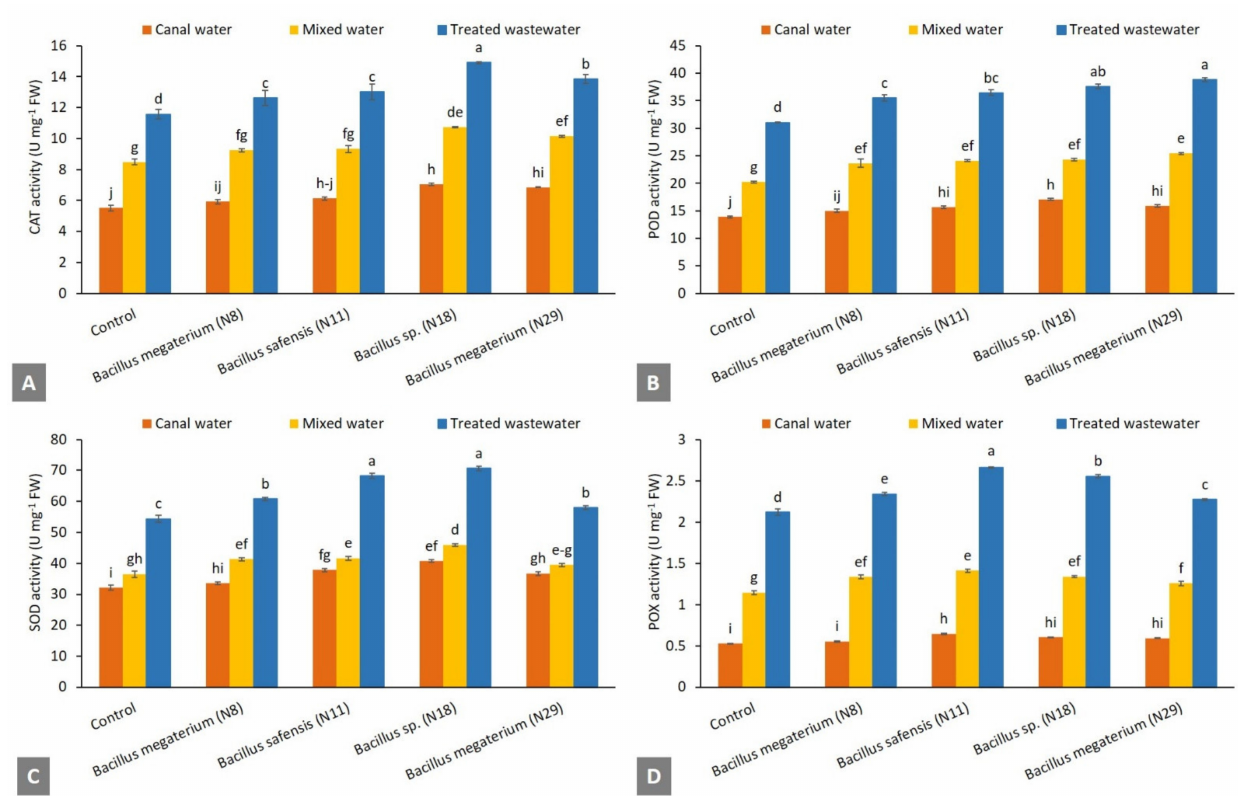
Figure 4. Effect of Pb-tolerant Bacillus strains on antioxidant enzymes: Catalase activity ( A ); Guaiacol peroxidase activity ( B ); Superoxide dismutase activity ( C ); and Peroxidase activity ( D ) of spinach plants under wastewater, mixed water, canal water conditions in pot trial; ( n = 4); Bars sharing different letters are statistically significant from each other at 5% level of probability; CAT = Catalase; POD = Guaiacol peroxidase; SOD = Superoxide dismutase; POX =